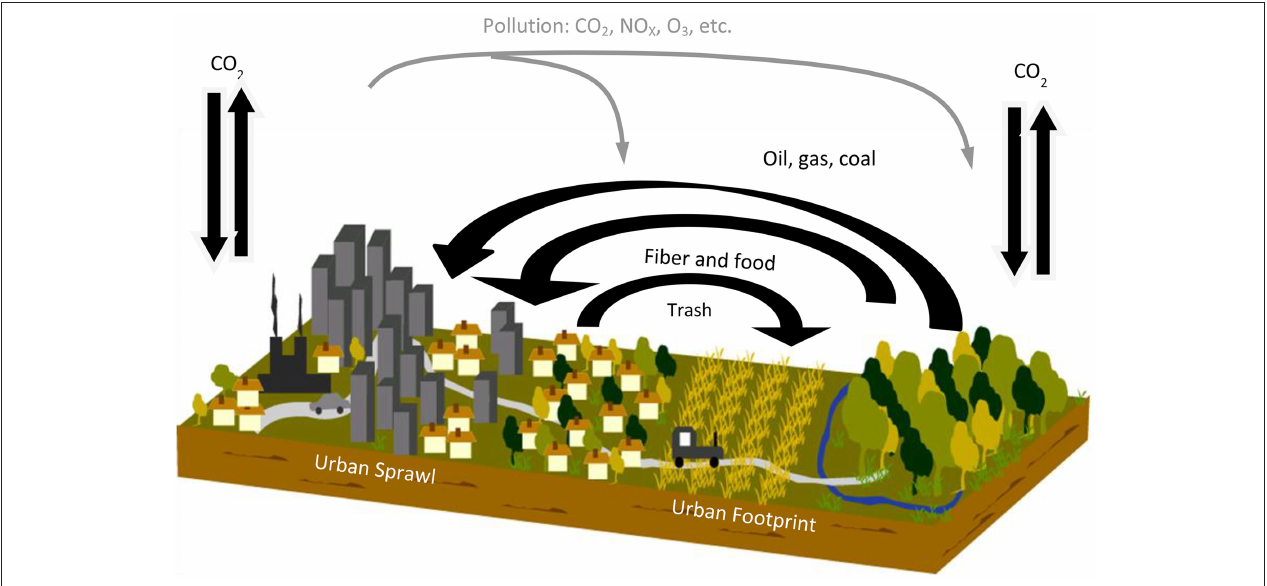
FIGURE 1 | Urban carbon cycle (modified after Churkina, 2008). Black arrows depict vertical and horizontal carbon fluxes. Gray errors show indirect effects of urban pollution on carbon uptake and release of ecosystems inside of urban sprawl and in the urban